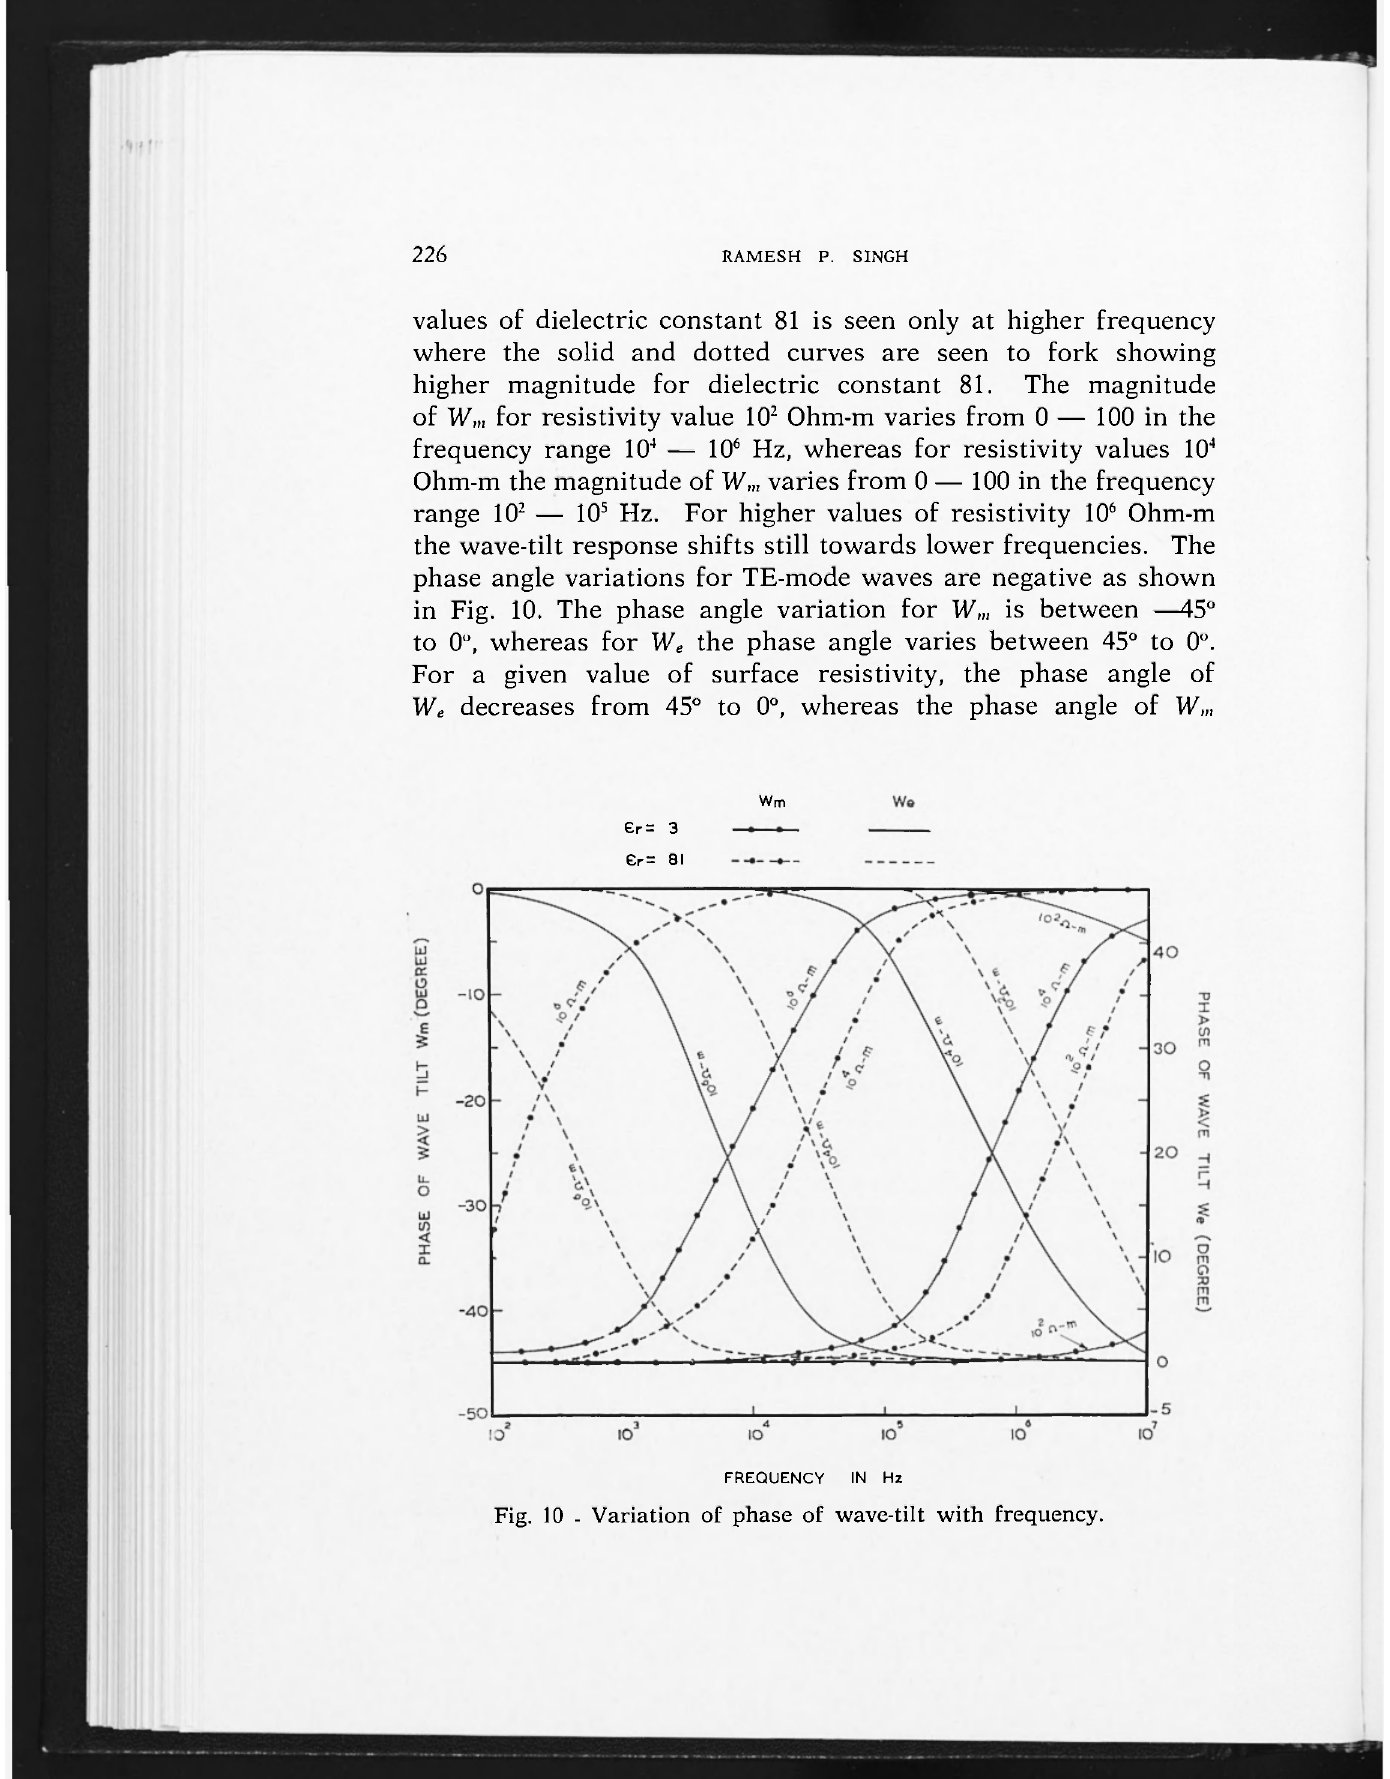
Fig. 10 - Variation of phase of wave-tilt with